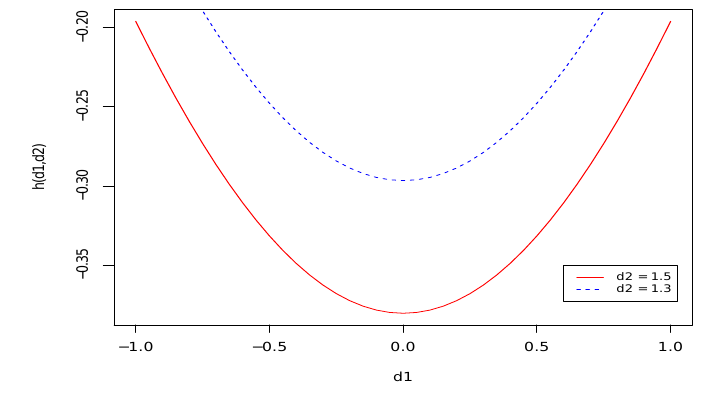
Figure 1: h ϕ ( d 1 , d 2 ) for fixed d 2 for normal r.v.s